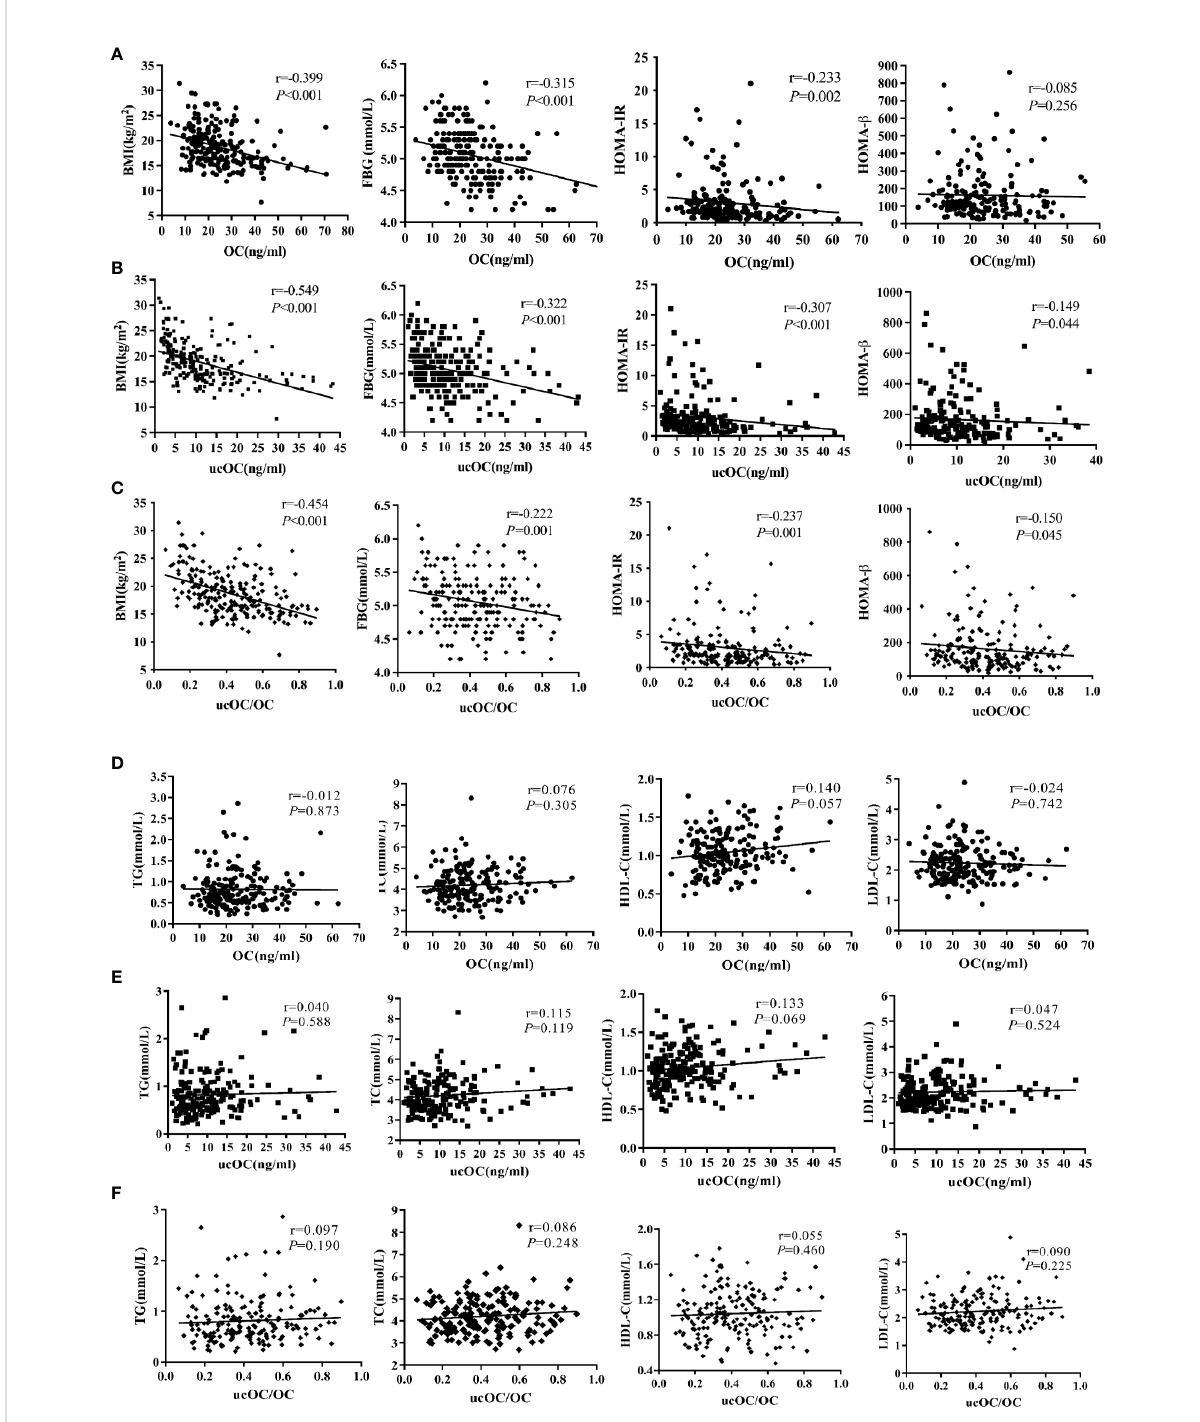
FIGURE 1 Associations between serum levels of OC, ucOC and ucOC/OC with glycolipid metabolic parameters in OI children. (A) Correlation between serum OC level and glucose metabolic parameters. (B) Correlation between serum ucOC level and glucose metabolic parameters. (C) Correlation between ratio of ucOC/OC and glucose metabolic parameters. (D) Correlation between ratio of OC level and lipid metabolic parameters. (E) Correlation between ratio of ucOC level and lipid metabolic parameters. (F) Correlation between ratio of ucOC/OC and lipid metabolic